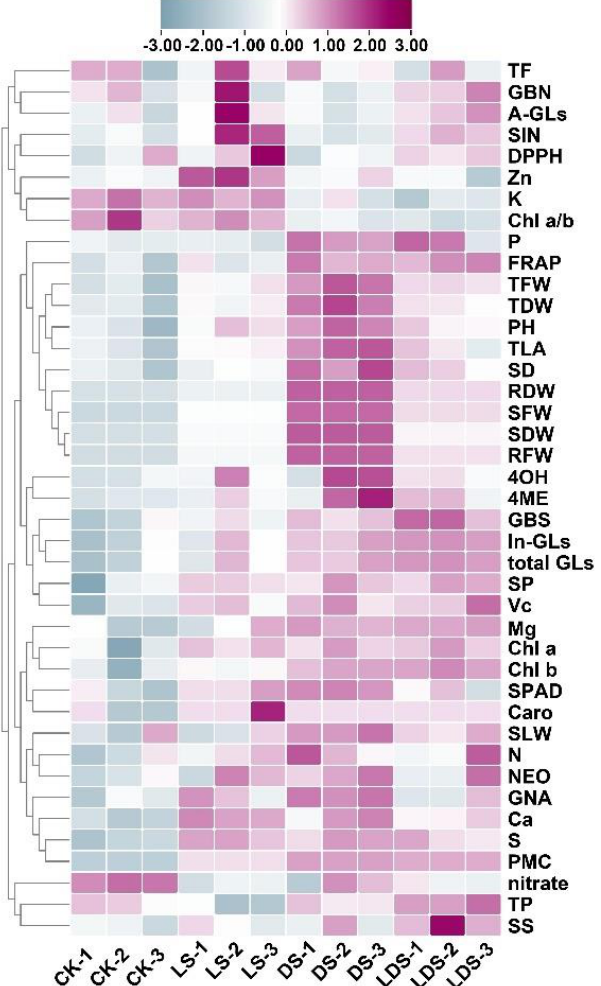
Figure 2. Cluster heatmap analysis summing up the morphology and quality of kale in CK and supplemental UV-A light treatments. A false-color scale with purple as an increased parameter, while blue represents a decreased parameter was used to visualize the results. “LS” = Light-UVA Supplementation, “DS” = Dark-UVA Supplementation, “LDS” = Light/Dark-UVA Supplementation, “PMC” = plant moisture content, “SAW” = specific area weight, “PH” = plant height, “TFW” = total fresh weight, “RDW” = root dry weight, “SD” = stem diameter, “SFW” = shoot fresh weight, “RFW” = root fresh weight, “SDW” = shoot dry weight, “RFW” = root fresh weight, “TDW” = total dry weight, “TLA” = total leaf area, “TP” = total phenolic, “SS” = Soluble sugar, “TF” = total flavonoids, “SP” = soluble protein, “Vc” = Vitamin C, and the full names of all GLS variants has been described in Figure 1.